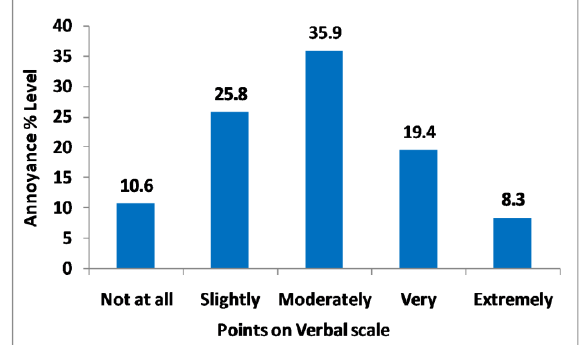
Figure 3. Noise annoyance percentage levels on the 5-point verbal scale